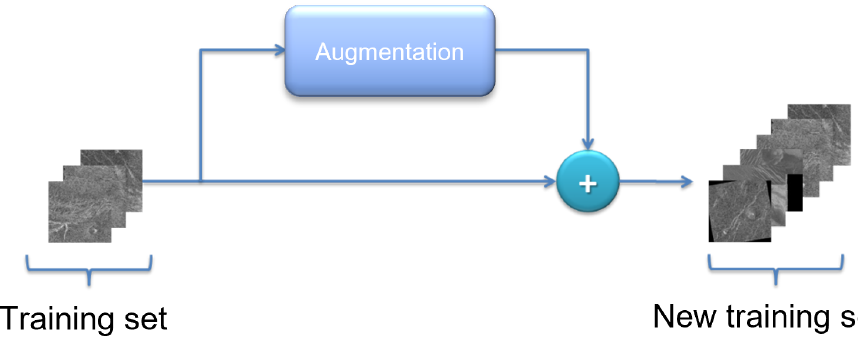
Figure 8. Schematic representation of dataset augmentation.